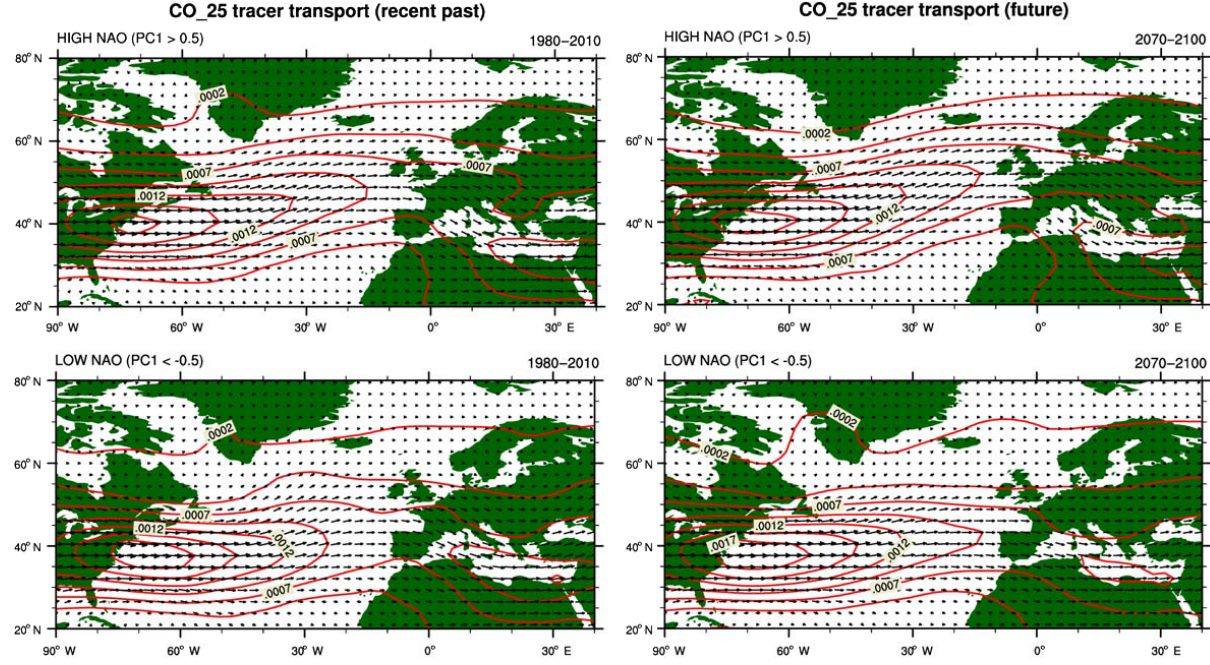
kg ) for winters with high NAO (PC1 > 0.5) (top) m · s mol